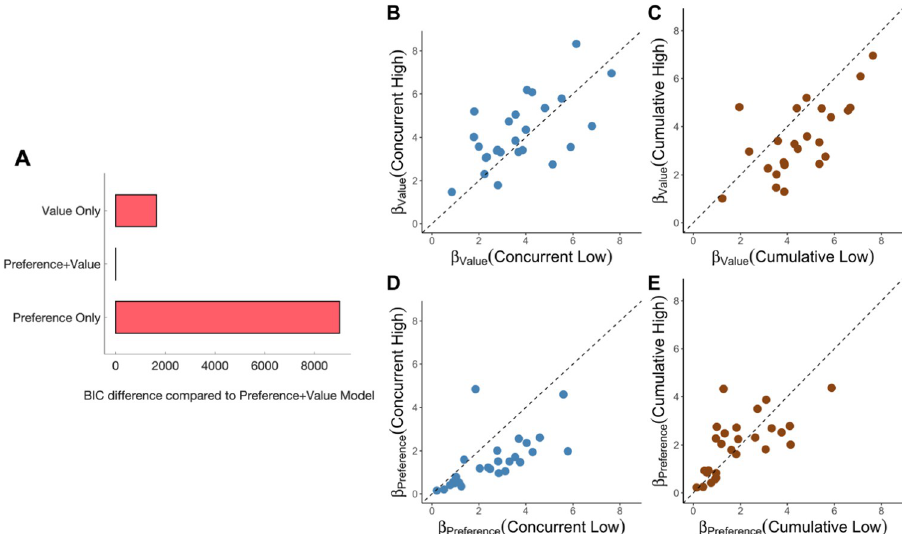
Fig 5. n = 27 subjects. A) Model comparison. Comparison of the combined Preference+Value model to models that learn only absolute values or relative preferences. The models are compared by means of the Bayesian Information Criterion (BIC; [36]). Lower BIC values indicate a more parsimonious model fit. B) Modeled Utilization of Value and Preference Learning. Individual subject model parameter fits showing the effects of concurrent and cumulative diversity on the degree to which preference and value learning manifested in subjects’ choices. Each dot represents a subject. Dashed lines mark where utilization of the form of learning is equal for low and high diversity.